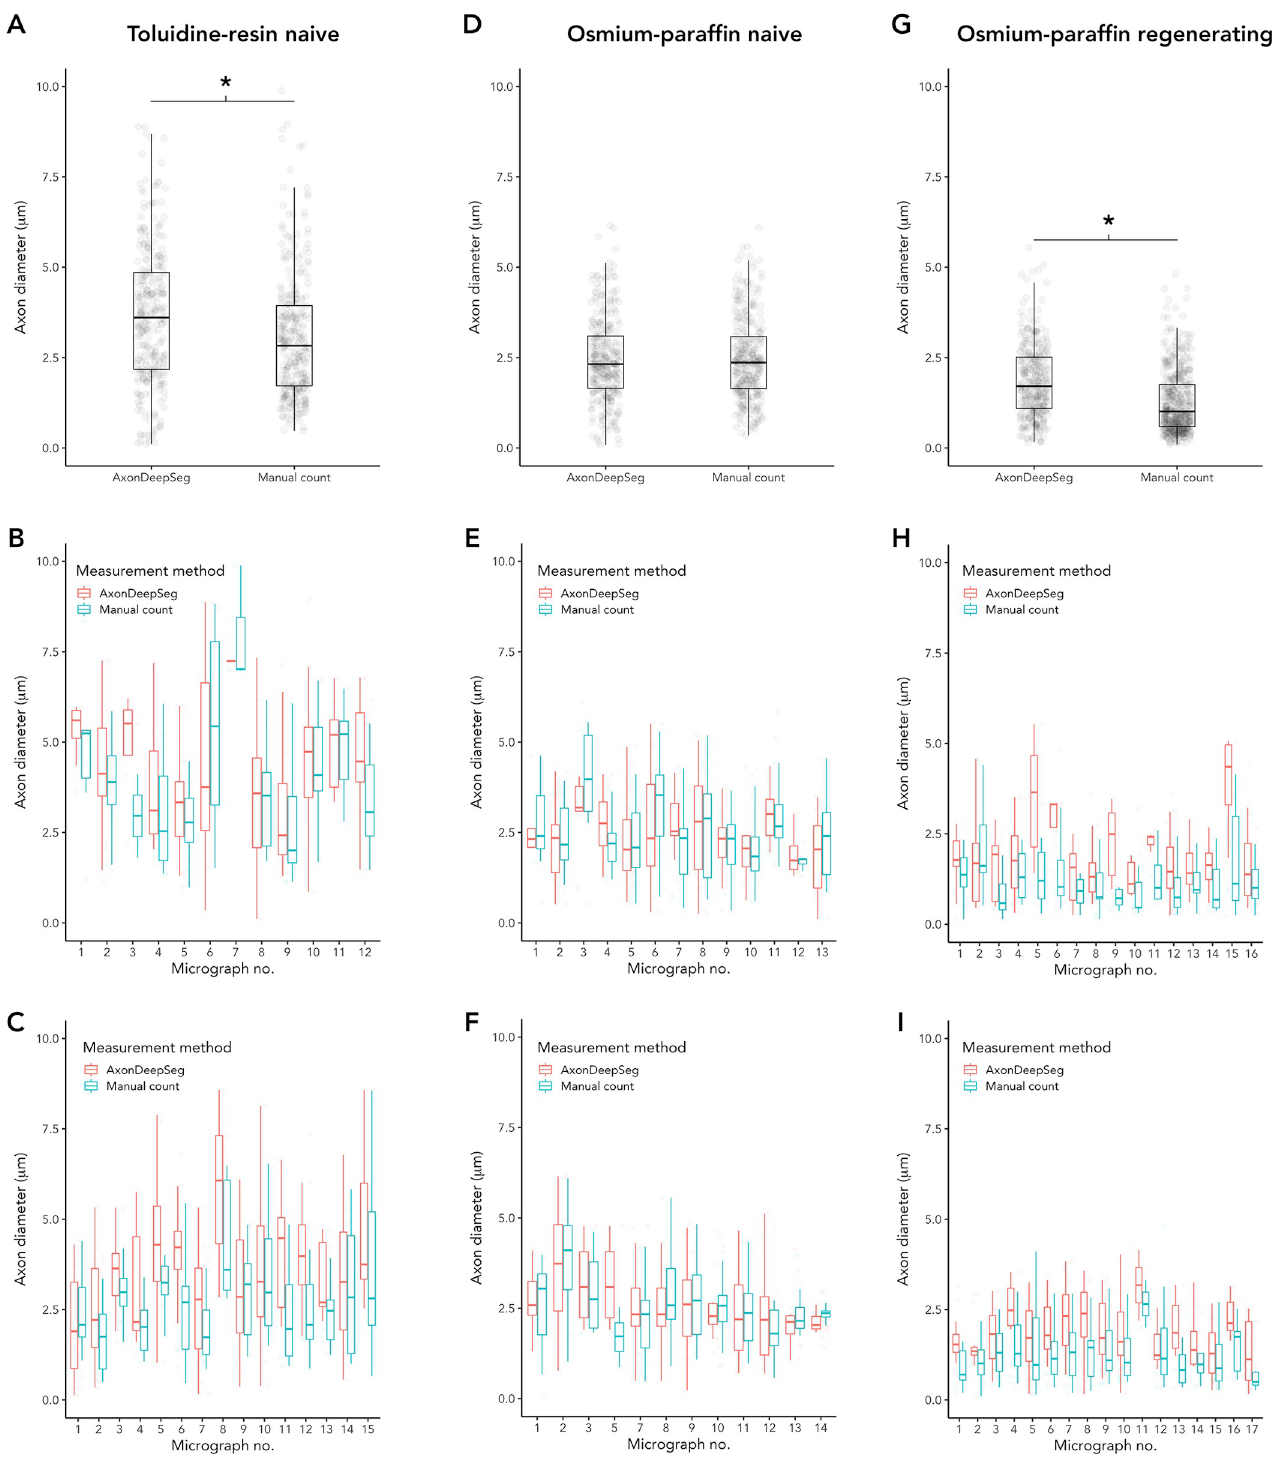
Fig 5. Comparison of axon diameters measured by ADS or manually. (A-C) Na ï ve nerves, toluidine-resin protocol; (A) Mean axon diameters for all micrographs for both nerves; (B) Mean axon diameters in each micrograph for nerve one; (C) Mean axon diameters in each micrograph for nerve two. (D-F) Na ï ve nerves, osmium-resin protocol; (D) Mean axon diameters for all micrographs for both nerves; (E) Mean axon diameters in each micrograph for nerve one; (F) Mean axon diameters in each micrograph for nerve two. (G-I) Regenerating nerves, osmium-paraffin protocol; (G) Mean axon diameters for all micrographs for both nerves; (H) Mean axon diameters in each micrograph for nerve one; (I) Mean axon diameters in each micrograph for nerve two. Asterisk ( � ) = significant (P < 0.05 by two-sample t-test). Boxes are 1 interquartile range (IQR), whiskers 1.5 � IQR.